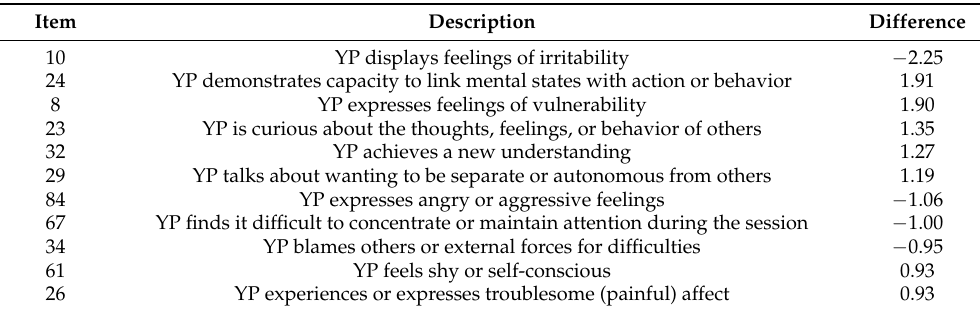
Table 5. Interaction structure differences measured in Z-scores on APQ items describing the young person’s (YP) actions and